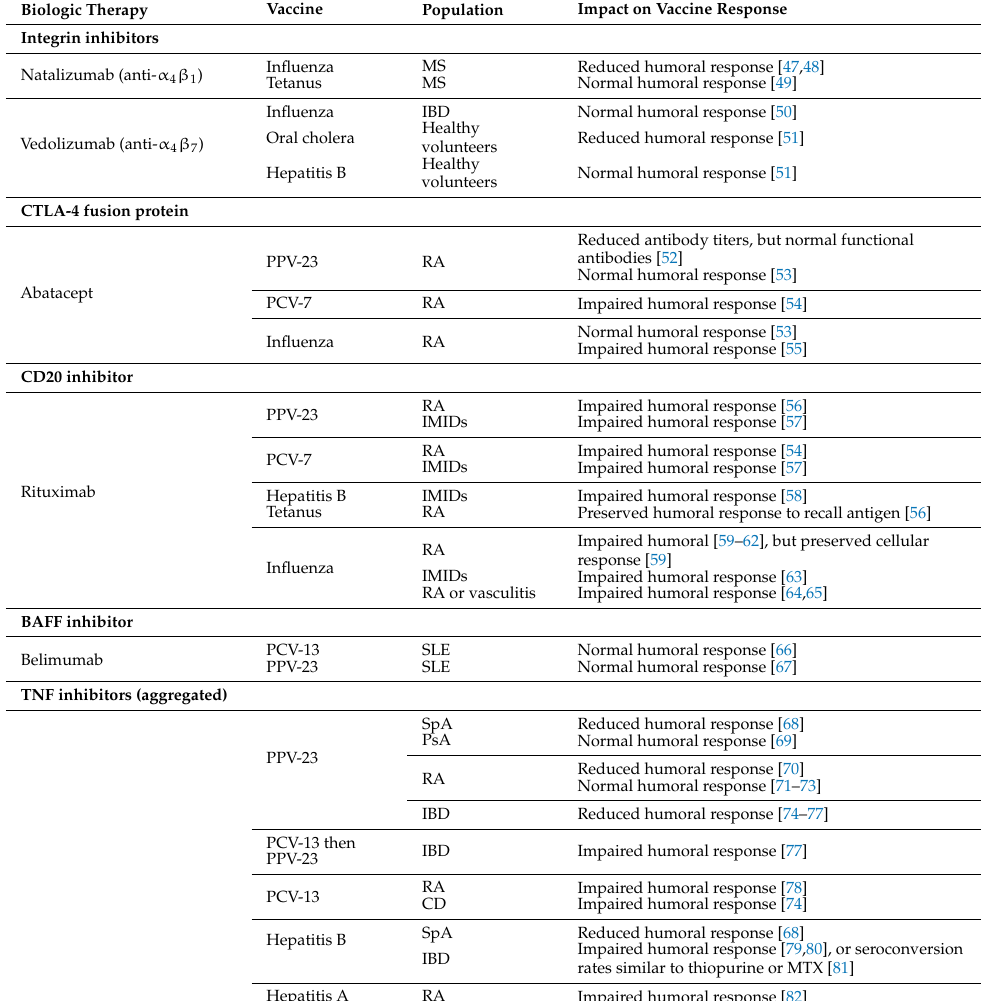
Table 1. Effect of biologic therapies on response to vaccination in IMID